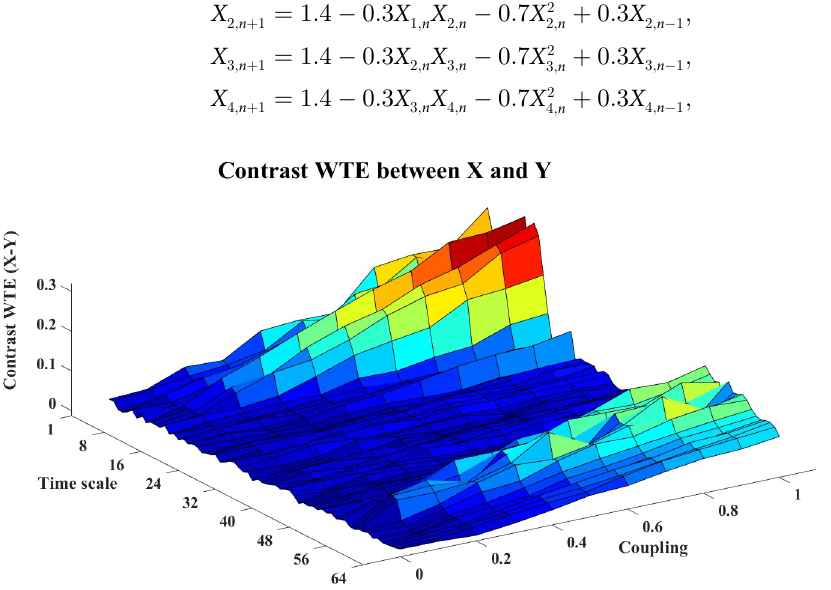
Fig 4. The contrast WTE information transfer values for the cosine map. In this figure, the 3D surface presents the contrast WTE O WTE , X ! Y , ( s i , e ) = WTE C , X ! Y ( s i , e ) − WTE C , Y ! X ( s i , e )(i = 1,2, ... 64,e = 0,0.1,0.2, ... ,1) for the cosine map at different time scale s i and coupling strength e. The non-negative surface indicates the directed information transfer from X- > Y.